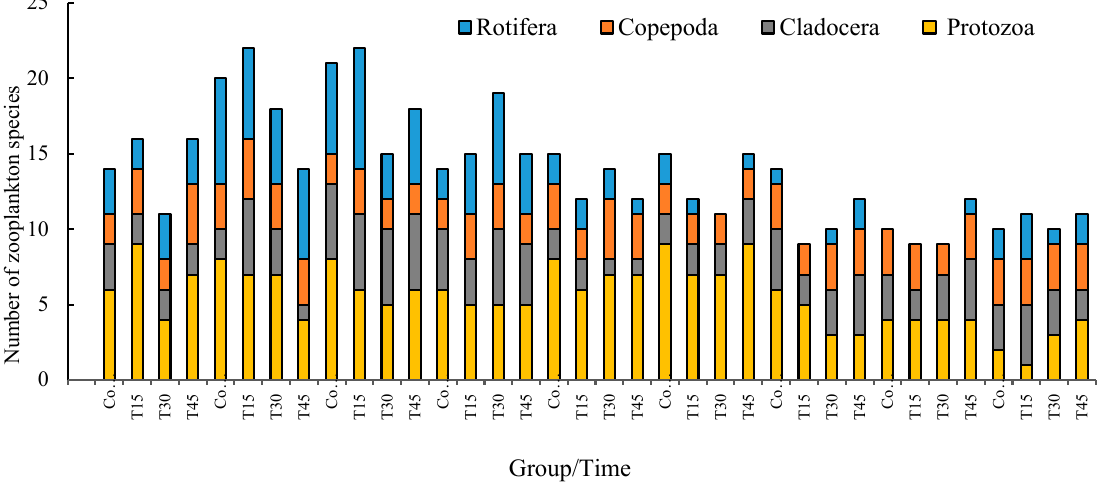
Figure 9. Species of zooplankton in different treatment groups during the experiment. The zooplankton species in different treatment groups during the experiment are listed in Table A6. The average biomass of Copepoda was the largest at 31.61 mg/L and accounted for 50.00% of the overall zooplankton biomass. That of Cladocera was 29.29 mg/L and accounted for 46.33% of the total biomass. These two groups accounted for 96.32% of the total average biomass. The average biomass of Protozoa was 1.76 mg/L, accounting for 2.79% of the total. The zooplankton group with the lowest average biomass was the rotifers, with only 0.56 mg/L, accounting for 0.89% of the total average biomass.